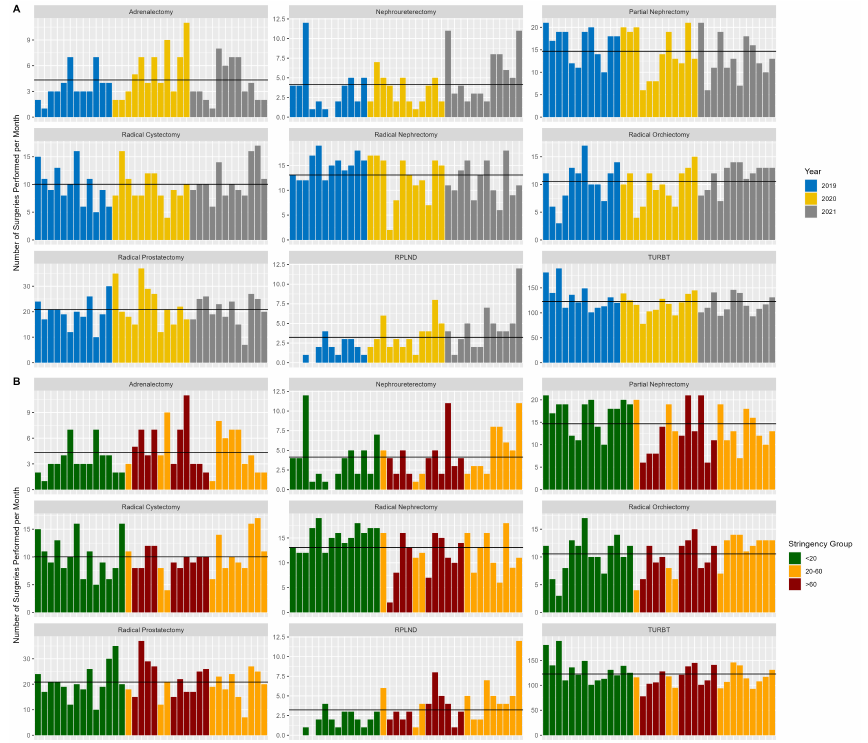
Figure 1. ( A ) Monthly urologic surgery volumes per year and subgroup analysis by surgery type. ( B ) Monthly surgical volumes per stringency category and subgroup analysis by surgery type. The horizontal black line indicates the overall mean number of